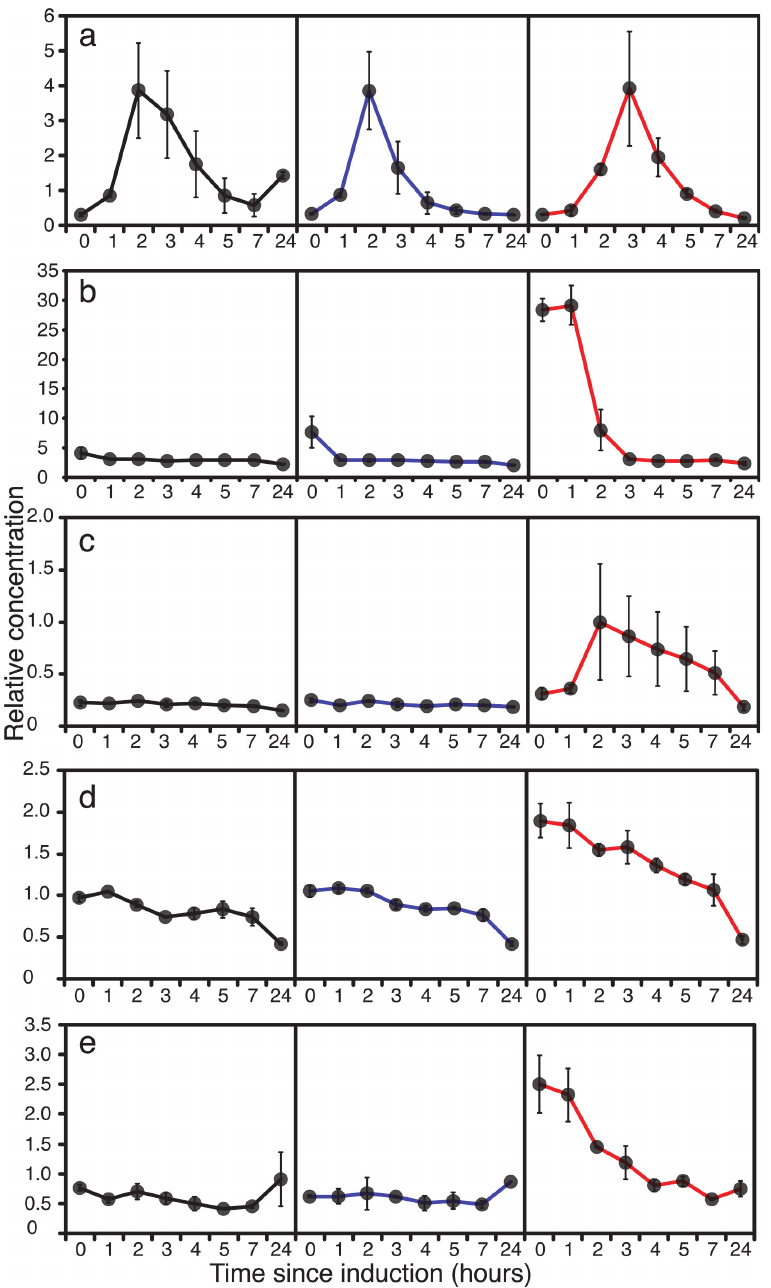
Fig 4. Metabolite accumulation profiles during fed-batch culture from 0 (before) to 24 hours after the start of methanol addition to wild-type GS115 (black), TRY1-1 (blue) and TRY1-3 (red), strains containing 1 and 3 gene copies of the human typsinogen gene, respectively, under the control of the AOX1 promoter. From top to bottom, panels represent a) formate (external), b) arabitol (external), c) trehalose (external), d) α / β -D-glucose (external), e) lactate (internal). Error bars show